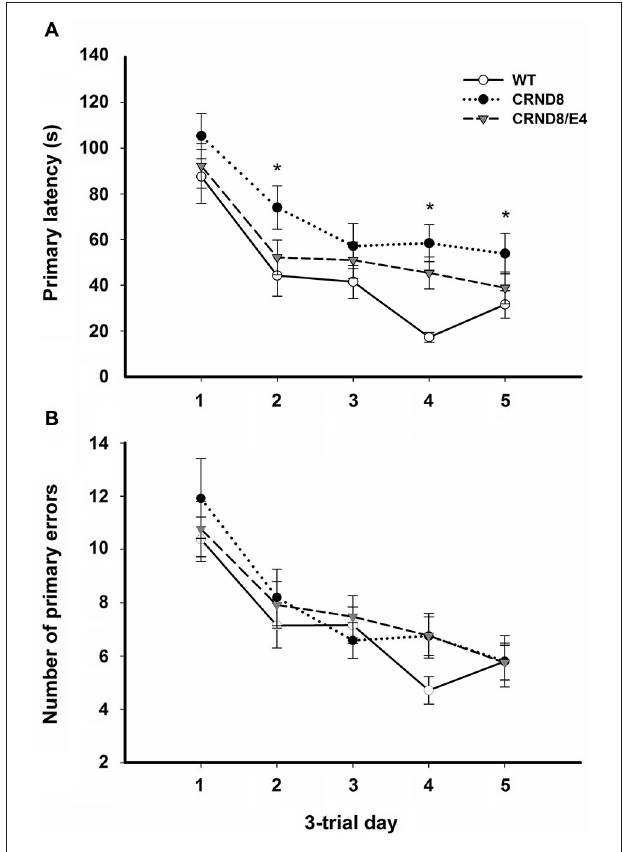
FIGURE 1 | Average primary latency and primary errors across genotypes in the Barnes maze, regardless of water condition. (A) Average primary latencies were significantly shorter for WT mice as compared to CRND8 mice ( p < 0.05), but not CRND8/E4s. Overall, there was a significant decrease across days in primary latency for all genotypes ( p < 0.001). (B) Average primary errors in the Barnes maze. Primary errors were not significantly different between any of the genotypes. All groups did, however, improve significantly over time ( p < 0.001). Points are mean ± SEM. * denotes p <